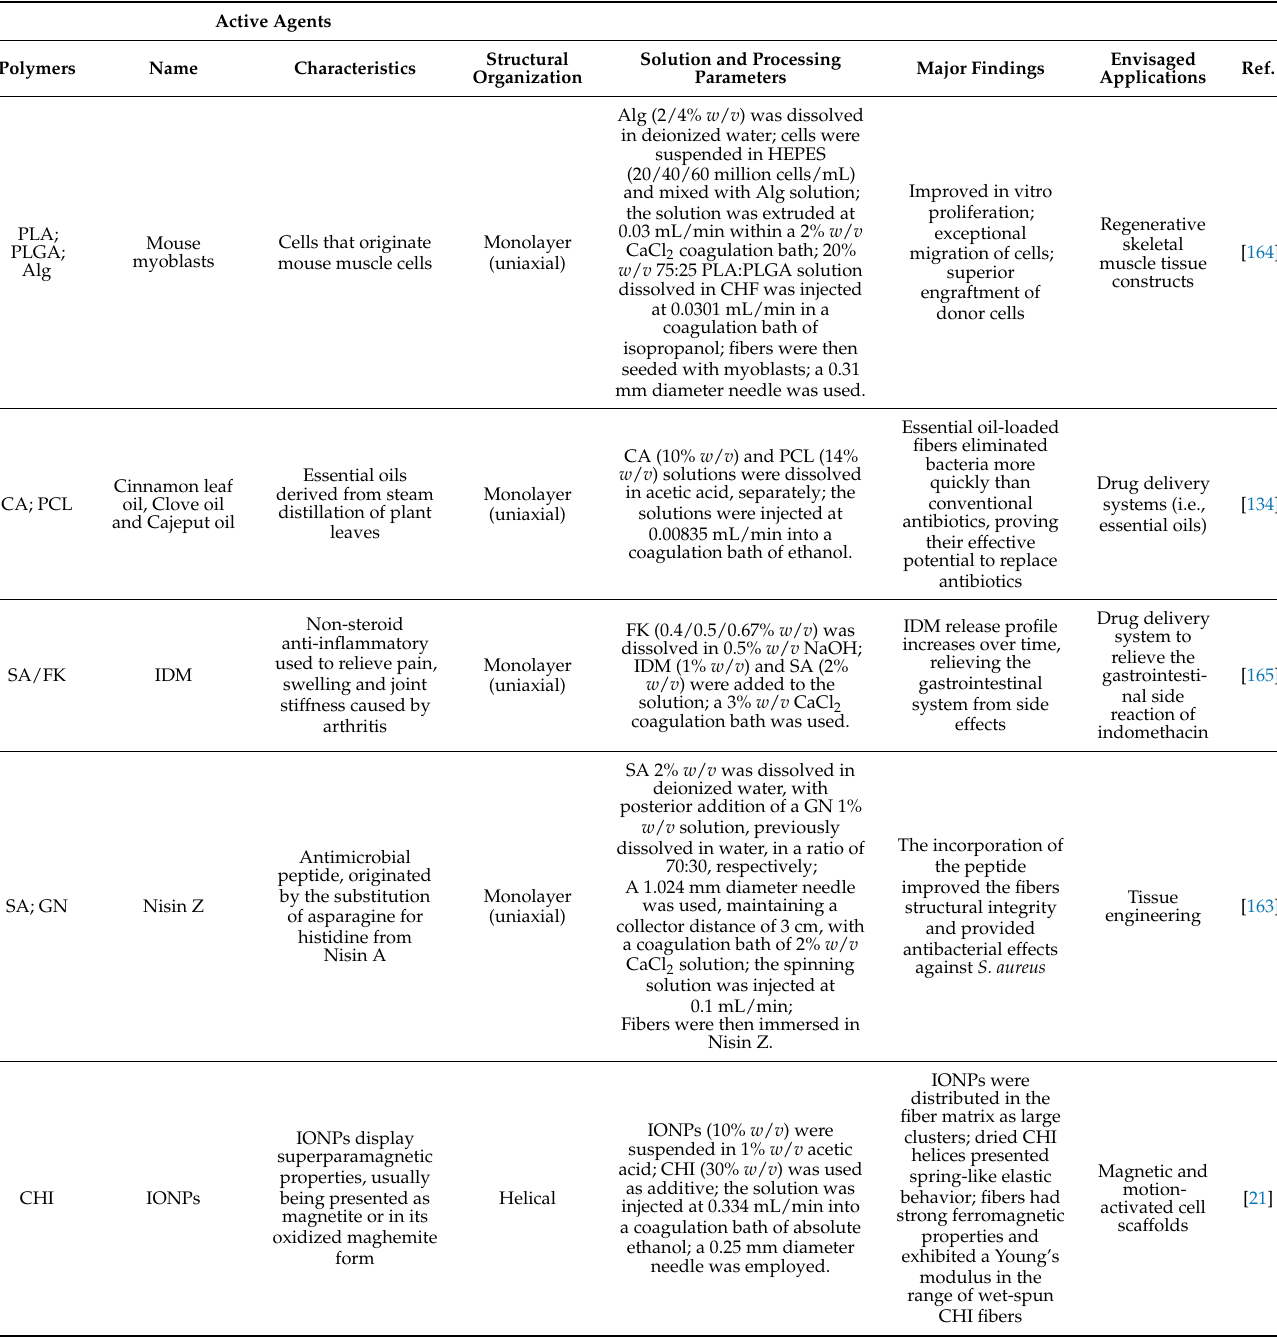
Table 2. Main applications of wet-spun fibers with various structural organizations and respective solution/processing